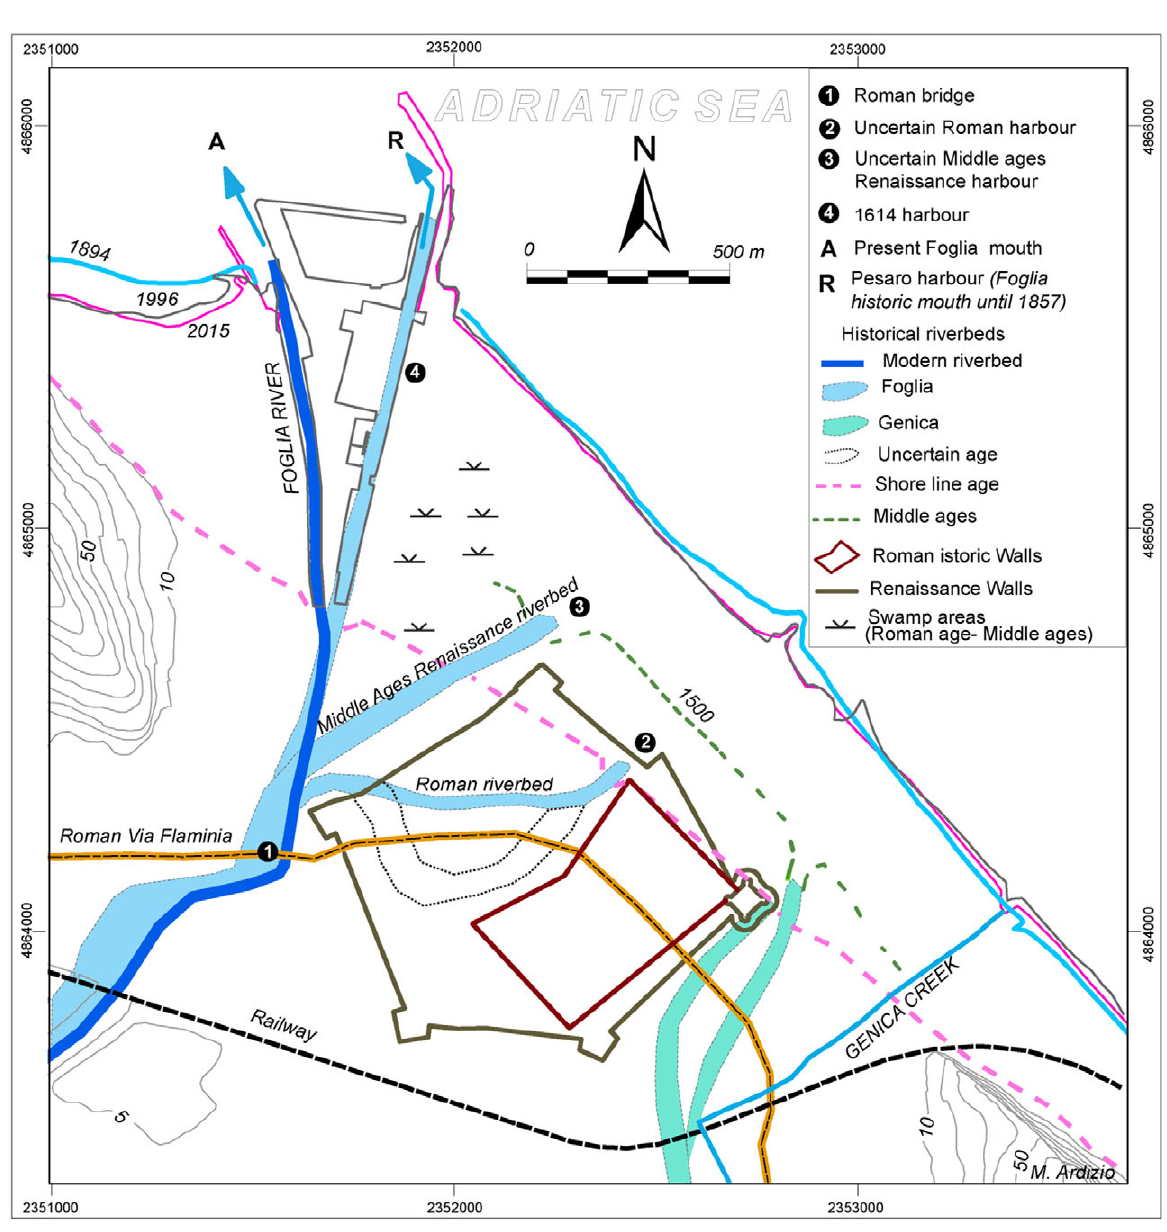
Fig. 4. Morpho-evolutive reconstruction of the Pesaro ( Pisaurum )